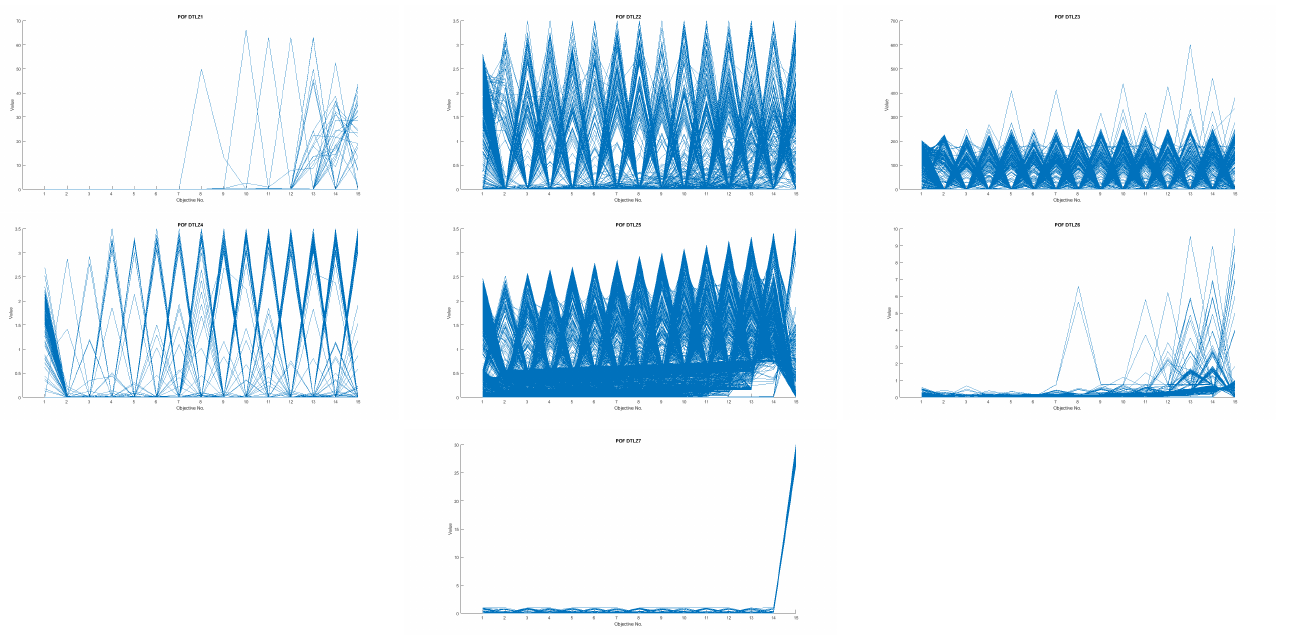
Figure 15. The plots of POF for DTLZ1-7 functions with 15 objectives using DB-CSA